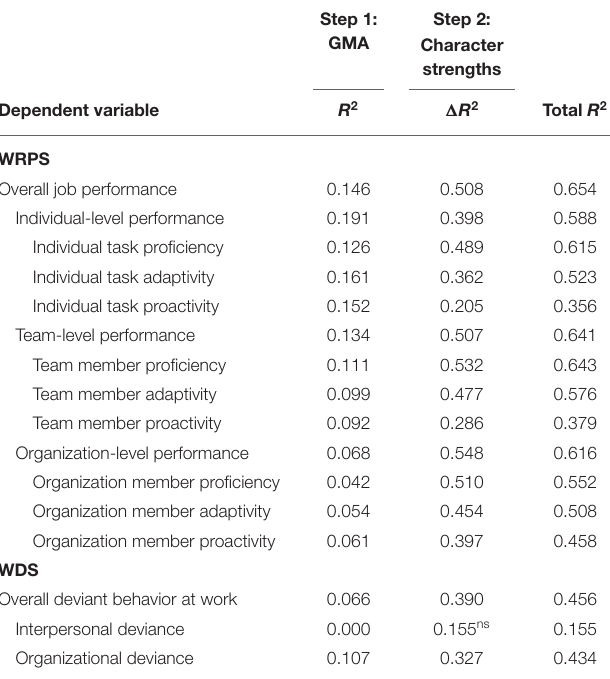
TABLE 5 | Hierarchical linear regression analyses: explained variance (Olkin–Pratt adjusted) in dependent variables by GMA (Step 1; method: Enter; CFT 20-R) and character strengths (Step 2; method: Enter; VIA-IS120 scales with partial correlation coefficients ≥ 0.25 in accordance with Table 4 ).